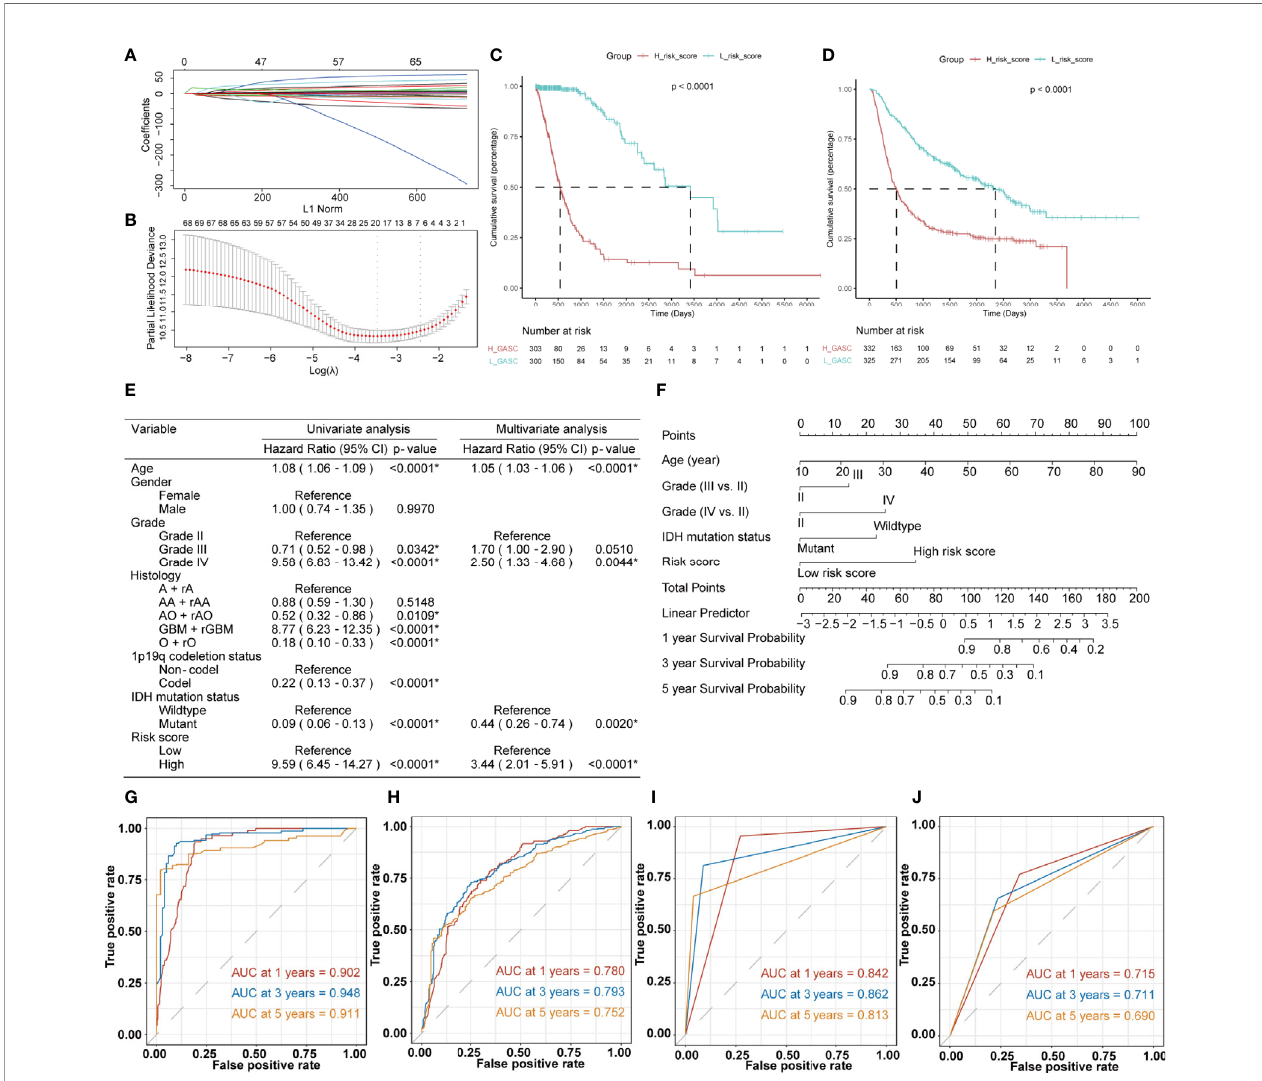
FIGURE 12 | Construction of the risk score system and establishment and validation of the nomogram survival model. (A, B) LASSO Cox regression analysis of training dataset. (C, D) Kaplan-Meier overall survival (OS) curves for samples in high- and low-risk score groups ( C for training dataset and D for validation dataset). (E) Uni- and multi-variate Cox regression analysis for prognostic model. *Statistical signi fi cance. (F) The nomogram for predicting 1-, 3 ‐ , or 5 ‐ year OS. (G, H) Time- dependent ROC curves of the nomogram prediction on the 1-, 3-, and 5-year survival rates ( G for training dataset and H for validation dataset). (I, J) Time- dependent ROC curves of the IDH mutation status prediction on the 1-, 3-, and 5-year survival rates ( I for training dataset and J for validation